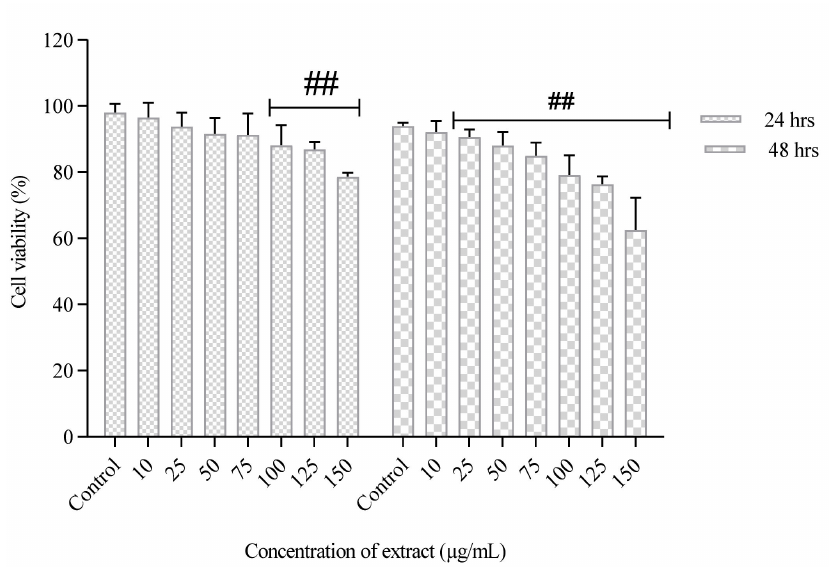
Figure 3. Cell viability of human lung cancer cells (A549) treated with PUFA-rich extract from Chlorella sp. S14. Bars represent mean ± SEM. Values are statistically different at ## p < 0.05 vs.